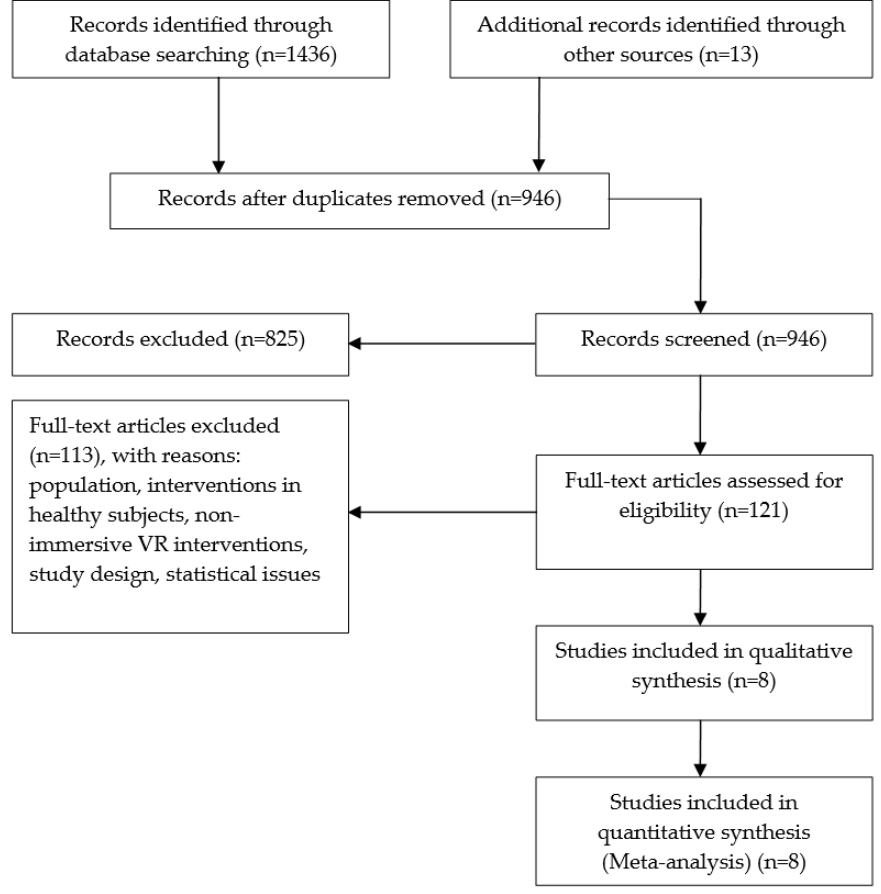
Figure 1. Consort diagram of study selection.